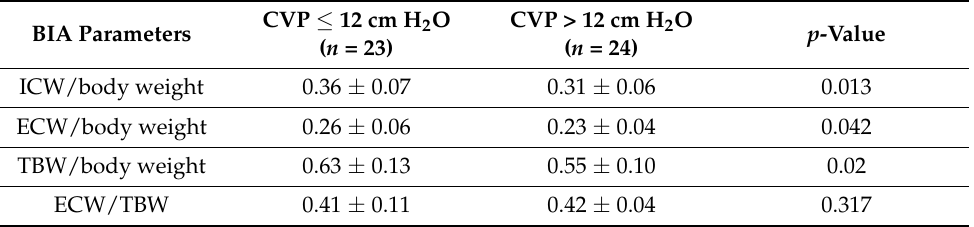
Figure 1. Frequency of distribution of hydration groups in different volemia groups according to central venous pressure (CVP) before the first procedure of renal replacement therapy. Table 2. The comparison of bioimpedance parameters before the first procedure of the renal replace- ment therapy in separate CVP groups.